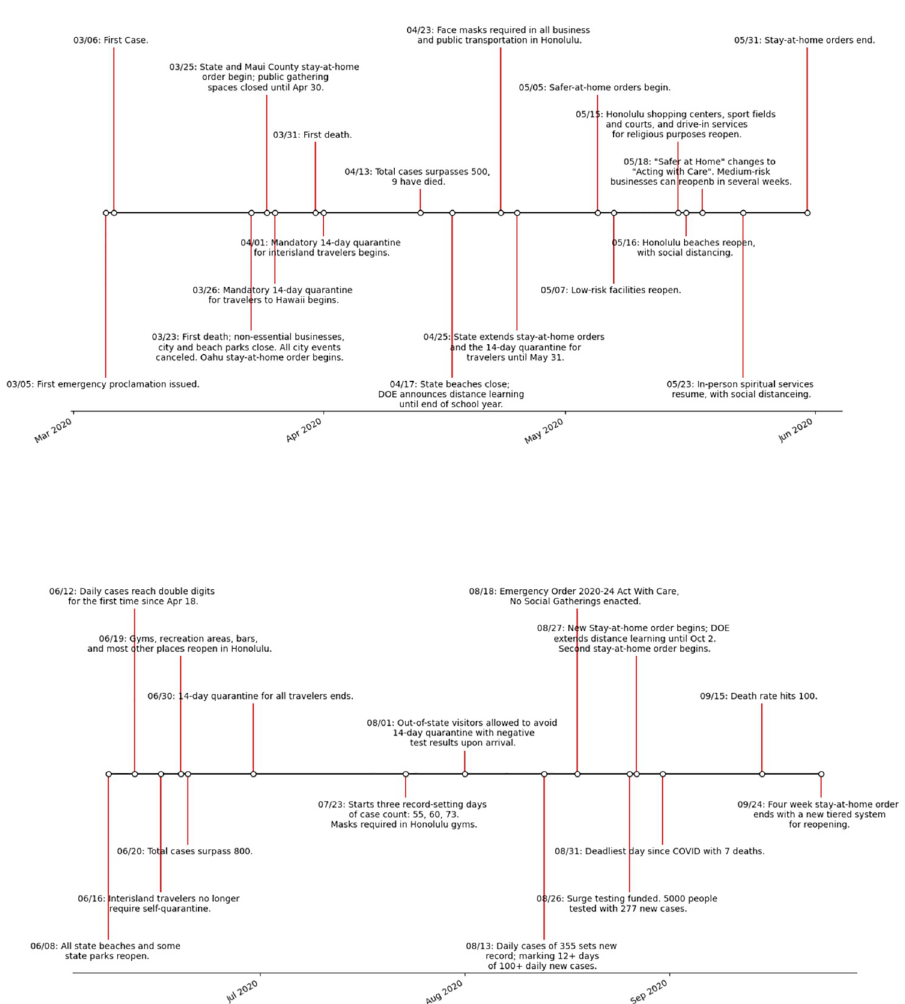
Fig 2. Hawai‘i Covid-19 mitigation timeline. Timeline of events related to the pandemic in the State of Hawai‘i from March 6, 2020 to September 24, 2020.